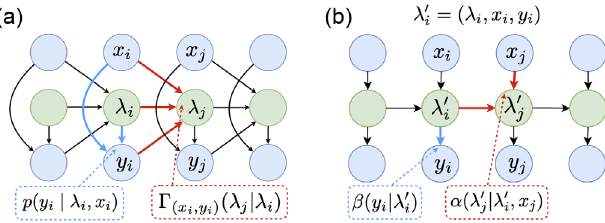
FIG. 3. (a) Ontological model in terms of Bayesian networks. (b) Standard hidden Markov